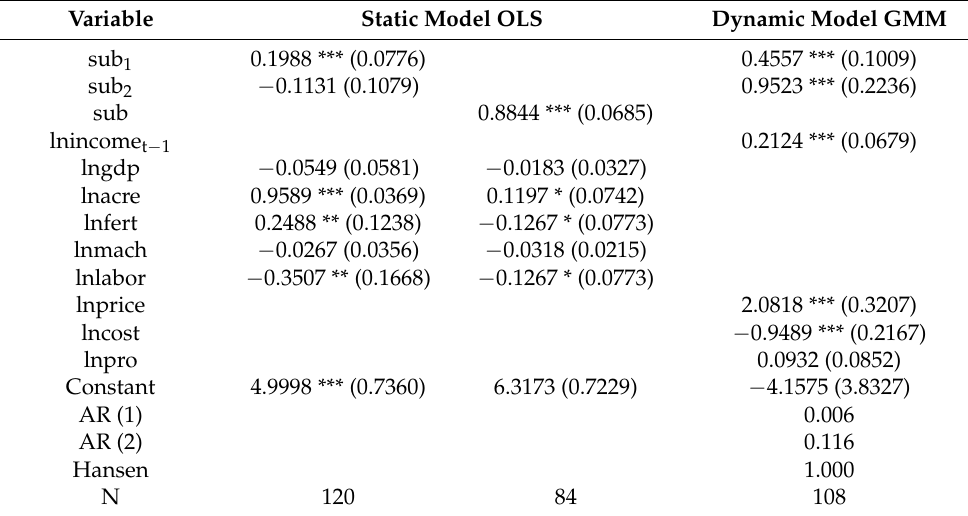
Table 4. Empirical results of the income effect of cotton subsidies in 12 provinces in China from 2011 to